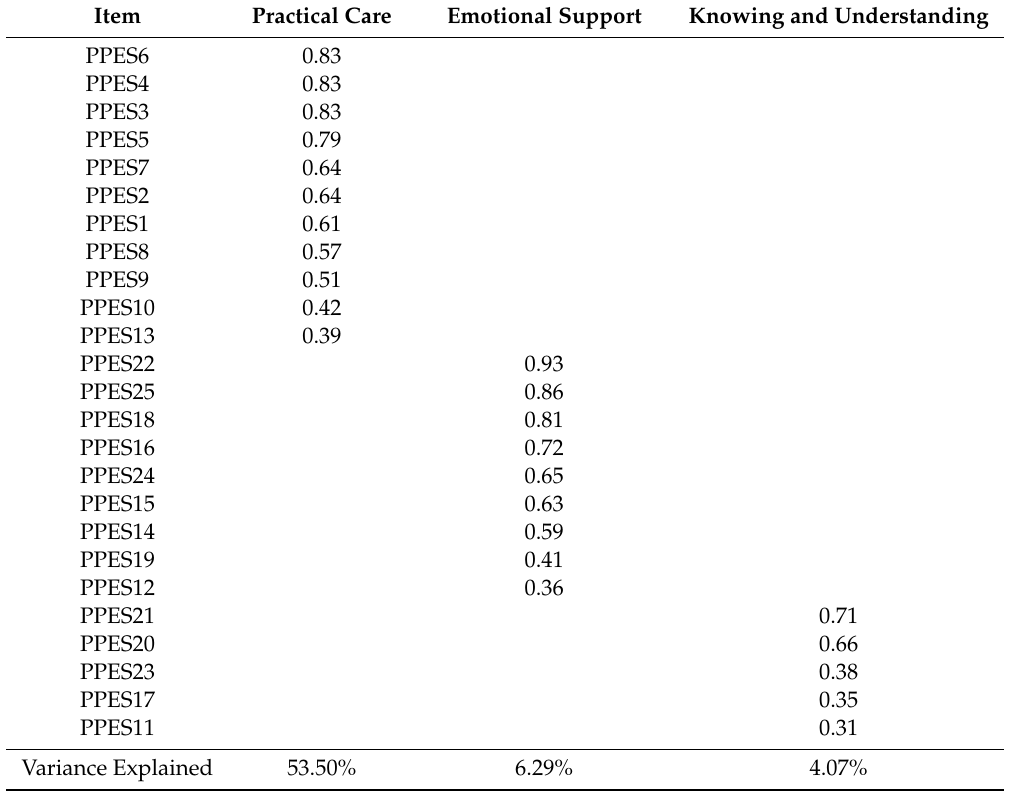
Table 4. Factor loadings for PPES-R.